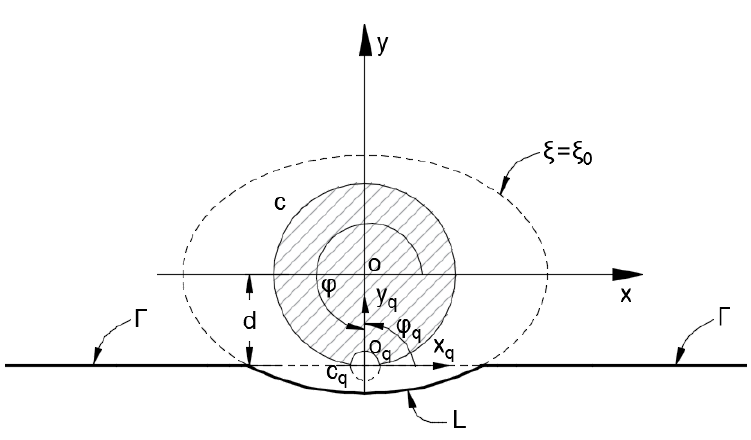
Figure 2. The scope of application of the extra-domain Mathieu function addition theorem.